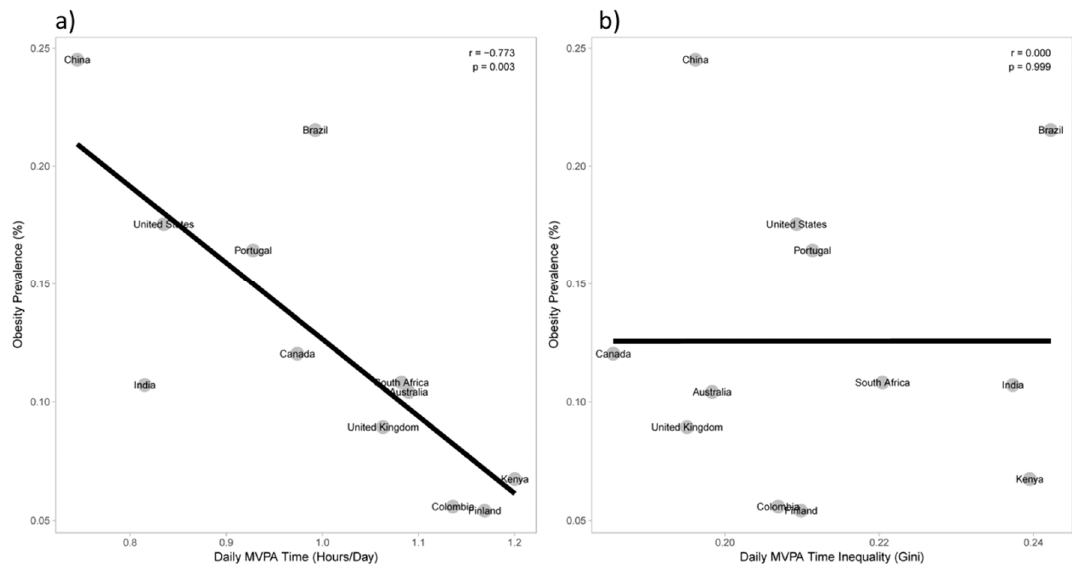
Figure 5. Association between moderate-to-vigorous physical activity (MVPA) and obesity. ( a ) shows the correlation between average MVPA and obesity, while ( b ) shows the correlation between MVPA inequality (Gini coefficient) and obesity. Boys and girls are combined for analysis. Correlation coefficients were compared using a Steiger’s Z-test ( p = 0.029), adapted from Chaput et al. [84].